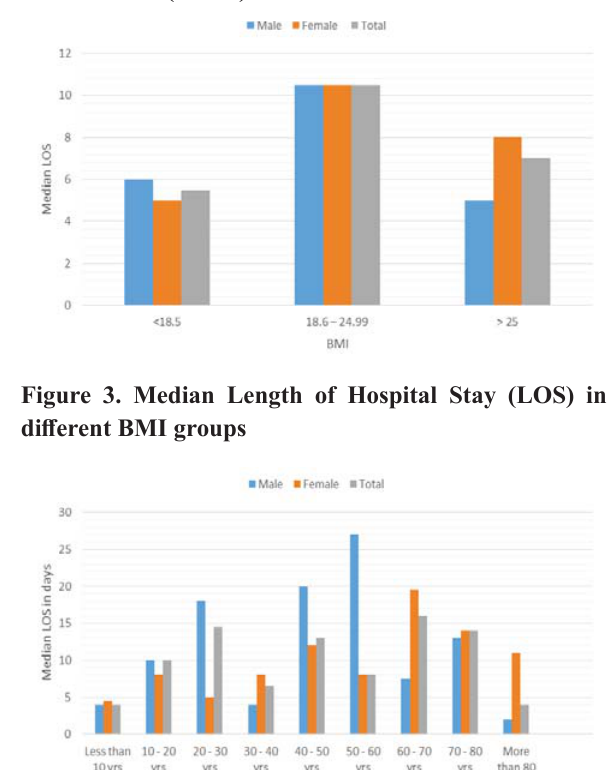
Figure 2. Patient distribution according to Total Body Surface Area (TBSA) involvement